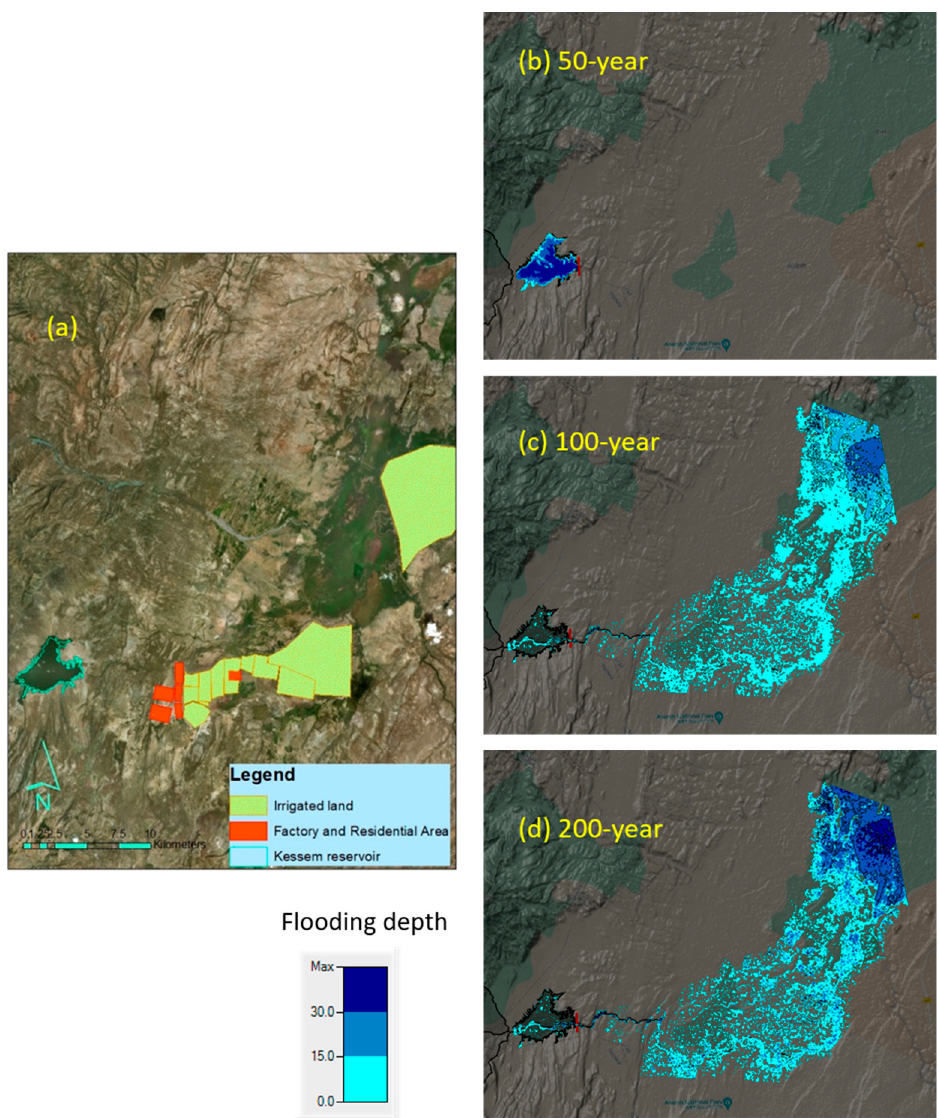
Figure 9. Hydraulic model outputs of inundation areas for various return periods: ( a ) the main infras- tructure and flooded area locations; and the ( b ) 50-year, ( c ) 100-year, and ( d ) 200-year return